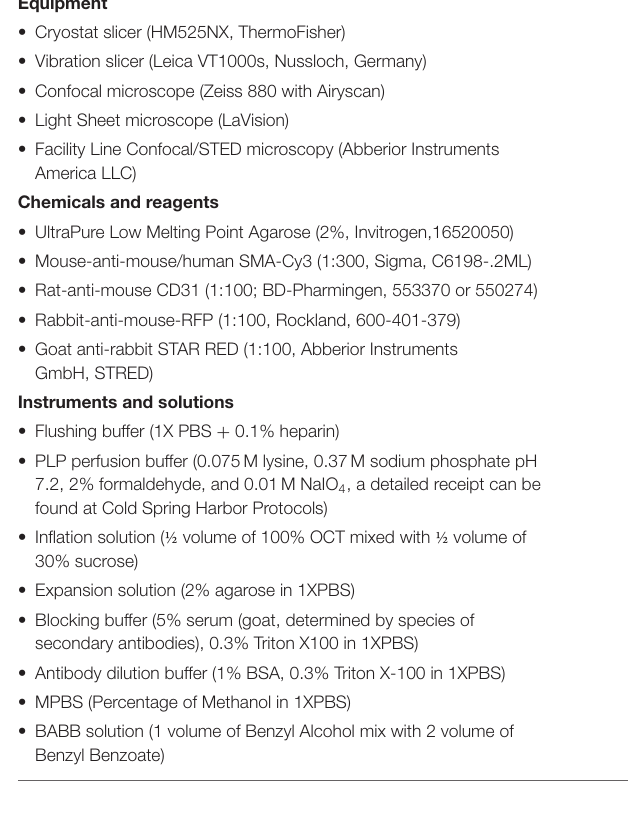
TABLE 1 | Equipment, Chemicals and reagents, Instruments and solutions used in the materials and methods.